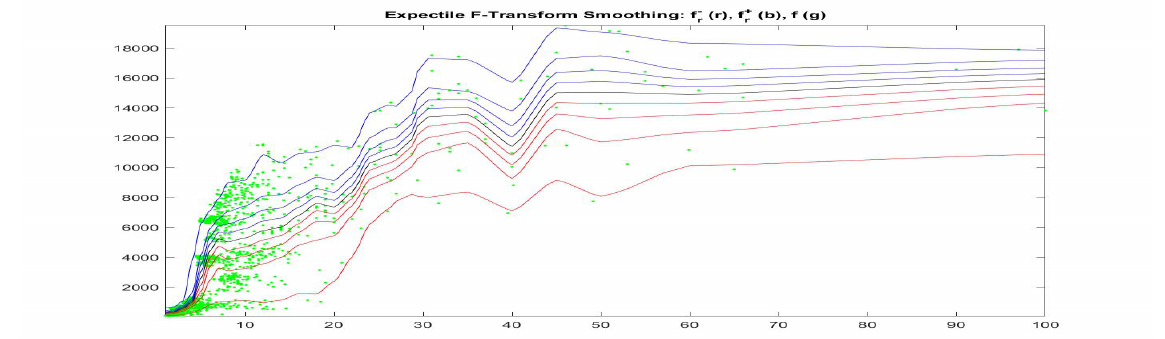
Figure 6. Fuzzy-valued Espectile F-transform function of the data-set ( BitCoin t , GT 100 t ) ; the five computed α -cuts correspond to α ∈ { 0.01,0.25,0.5,0.75,1 }